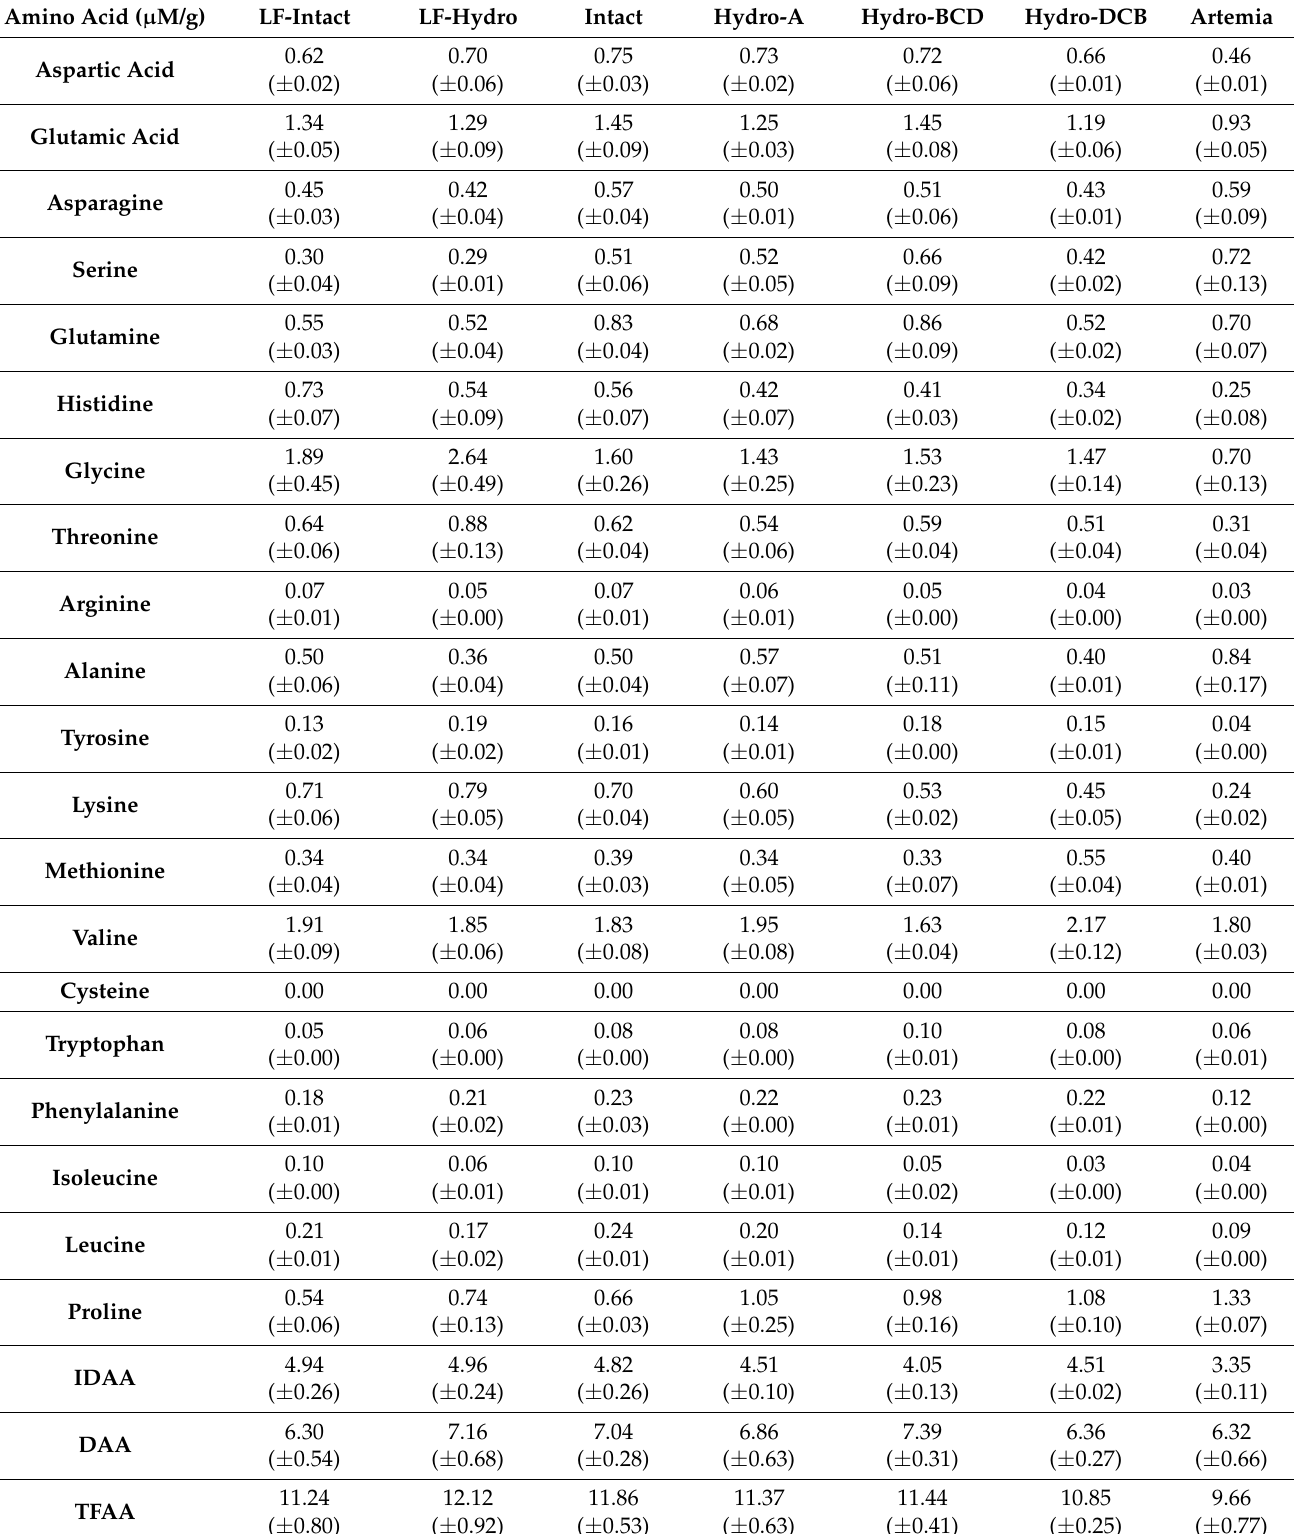
Table 6. Postprandial FAA composition in